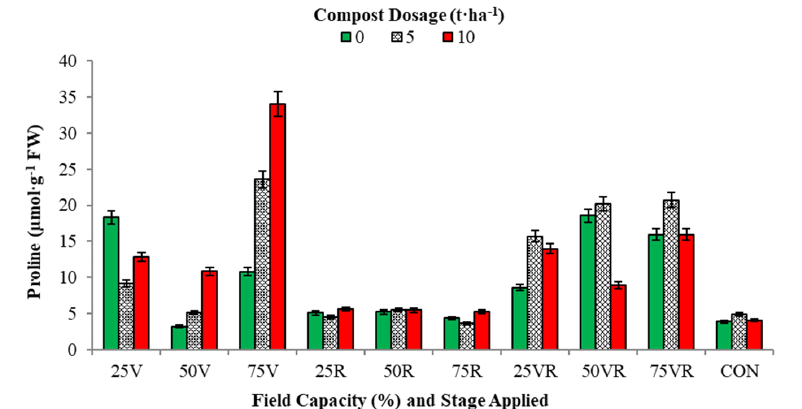
Figure 19. Effect of interaction of water regime, treatment stage and compost dosage on proline content of okra leaf at 5 weeks The 25, 50 and 75% represent field capacity; V (vegetative), R (reproductive), and VR (vegetative and reproductive) represent the stage at which the deficit was applied. Data in the interaction analysed with Least Squares Means, and means separated with LSD.